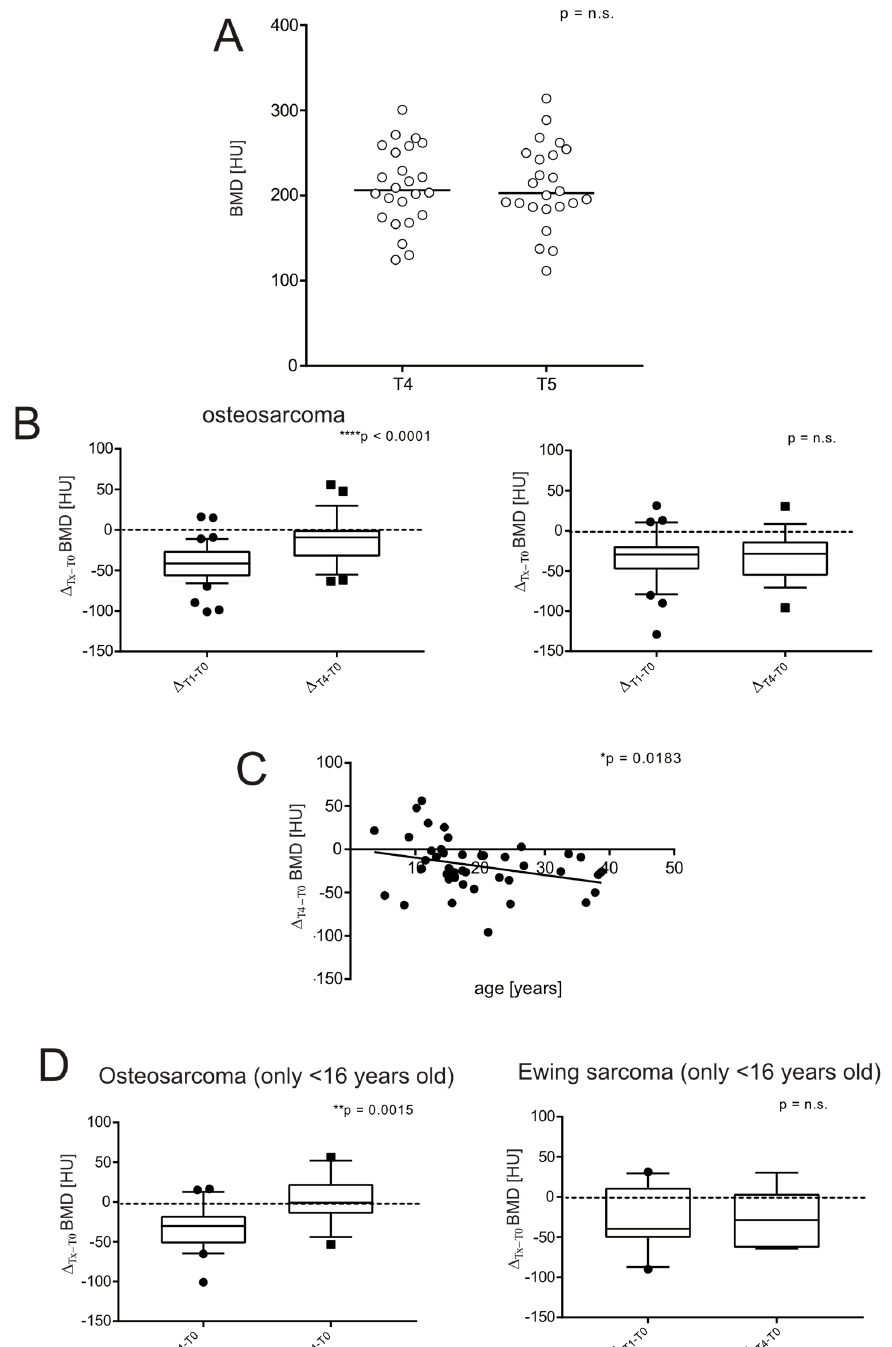
Figure 3. Long-term recovery of BMD: Ewing sarcoma had a worse prognosis. ( A ) BMD was measured by ROI attenuation level of T 12 vertebrae as assessed by CT in OS and EW merged together, at time points T4 and T5 ( n = 24, Wilcoxon paired test); ( B ) box plot of the difference of BMD values of Δ T1–T0 compared with the Δ T4–T0 difference in OS and EW ( n = 49 at T0 and 27 at T1 for OS and n = 30 at T0 and 17 at T1 for EW, Mann–Whitney U test, **** p < 0.0001); ( C ) correlation between the different of BMD values at 4 years from BMD values at diagnosis ( Δ T4–T0 ) and age at the onset ( n = 43, Spearman correlation test, * p < 0.05); ( D ) box plot of Δ T1–T0 BMD values compared to Δ T4–T0 BMD in OS and EW who were less than 16 years old at the onset ( n = 49 at T0 and 27 at T1 for OS and n = 30 at T0 and 17 at T1 for EW, Mann–Whitney U test, ** p < 0.001).